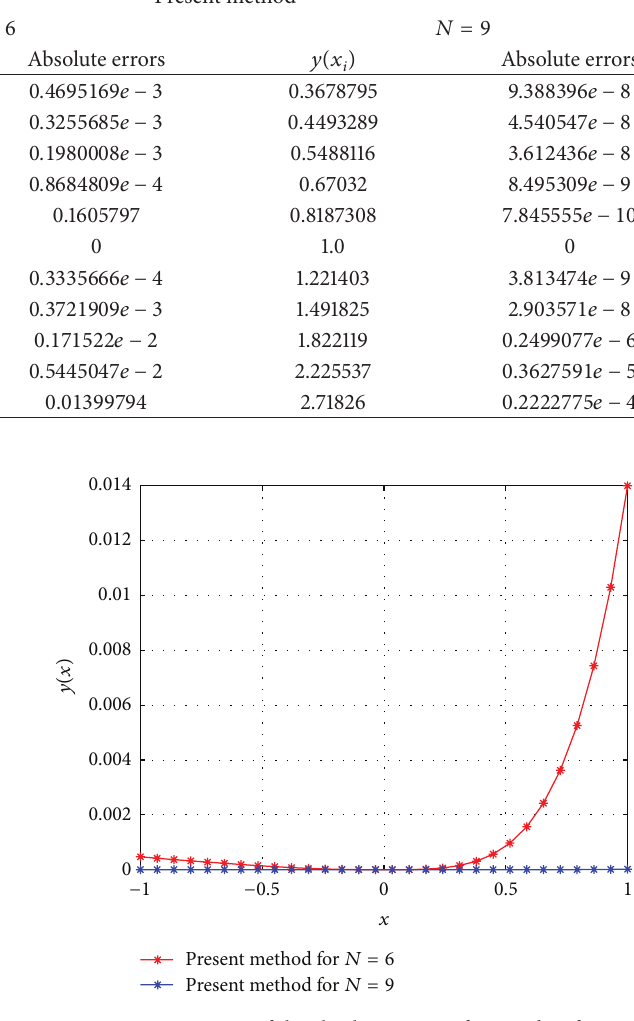
Figure 3: Comparison of the absolute errors of Example 3 for 𝑁 = 6, 9